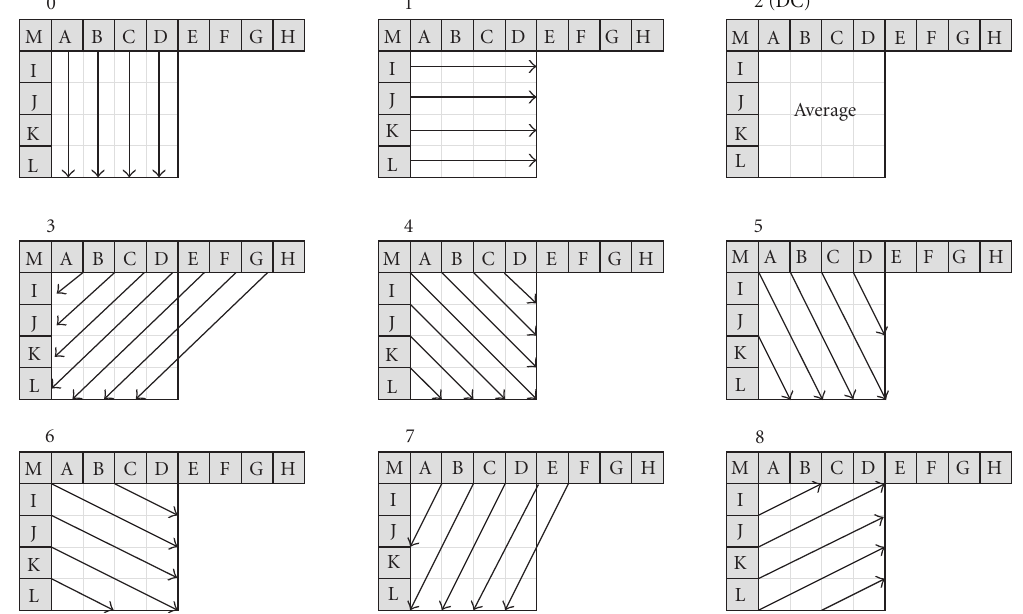
Figure 4: Nine possible prediction modes for I4MB